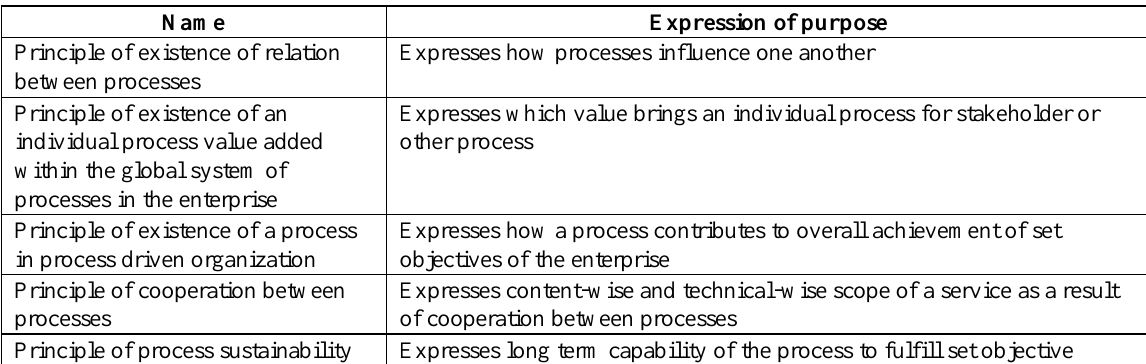
Table 3 . Principles influencing positioning of the behavioral elements in the holistic layer of the enterprise architecture Name